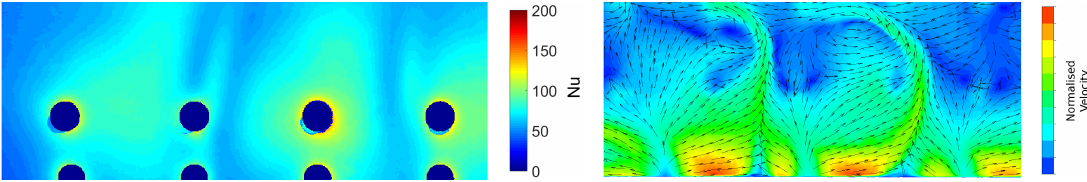
Figure 13. Detailed view of measured high heat transfer region between jets (experimental Nusselt number) with CFD near-wall velocity contour for the same region.